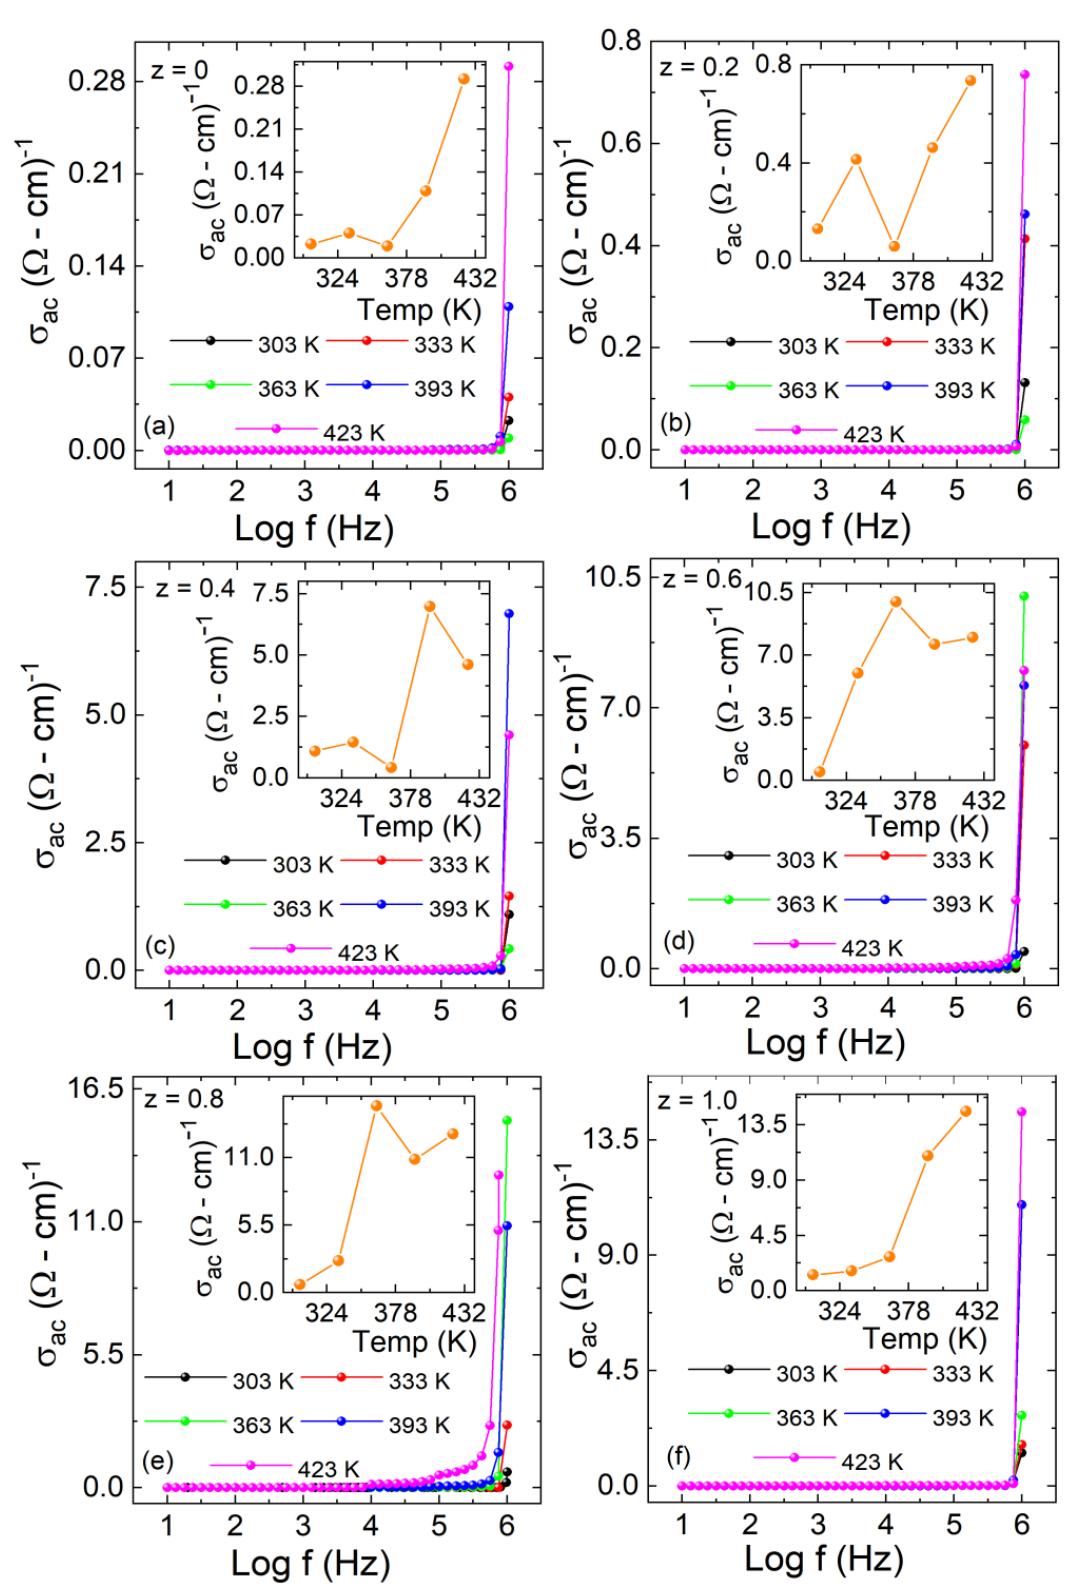
Figure 11 ( a – f ) Ac conductivity ( σ ac ) versus Log f graph for La 2 Co 1−z Fe z MnO 6 (z = 0, 0.2 – 1.0). Inset of Figure 11. ( a – f ) Ac conductivity ( σ ac ) versus Log f graph for La 2 Co 1 − z Fe z MnO 6 (z = 0, 0.2–1.0). Inset ( a – f ) represents the temperature-dependent Ac conductivity part of each plot. of ( a – f ) represents the temperature-dependent Ac conductivity part of each